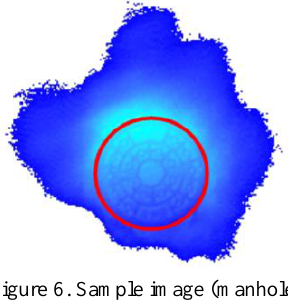
Figure 6. Sample image (manhole)